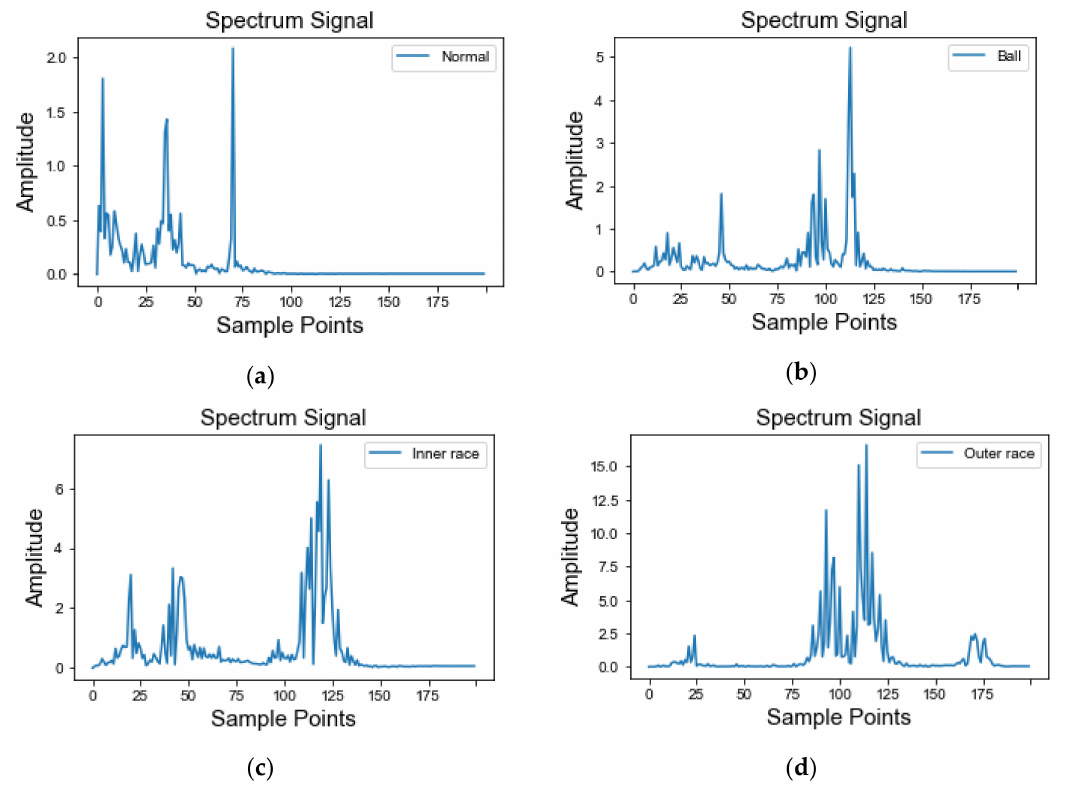
Figure 7. Spectrum signals of different health states, processed by VMD: ( a ) normal state; ( b ) ball fault; ( c ) inner race fault; ( d ) outer race